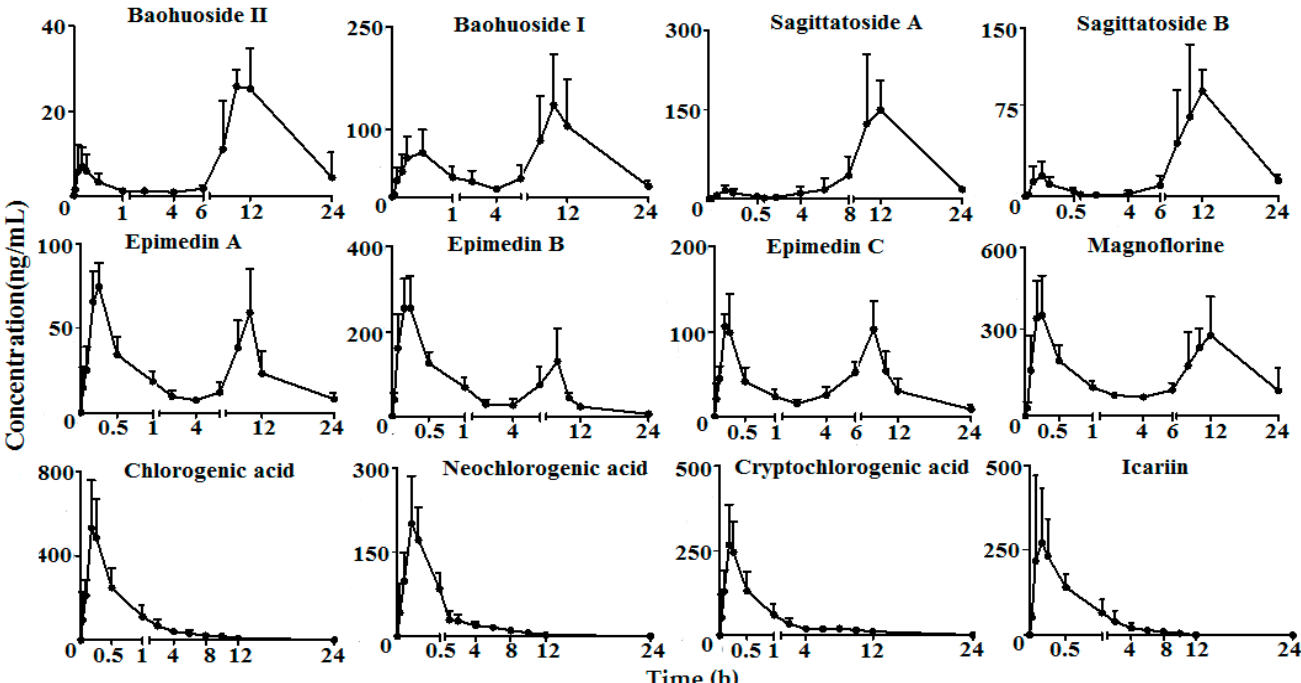
Figure 2. Mean plasma concentration–time curves of baohuoside II, baohuoside 1, sagittatoside A, sagittatoside B, epimedin A, epimedin B, epimedin C, magnoflorine, chlorogenic acid, neochlorogenic acid, cryptochlorogenic acid and icariin in six rats after oral administration of Epimedium extract (mean ± SD).